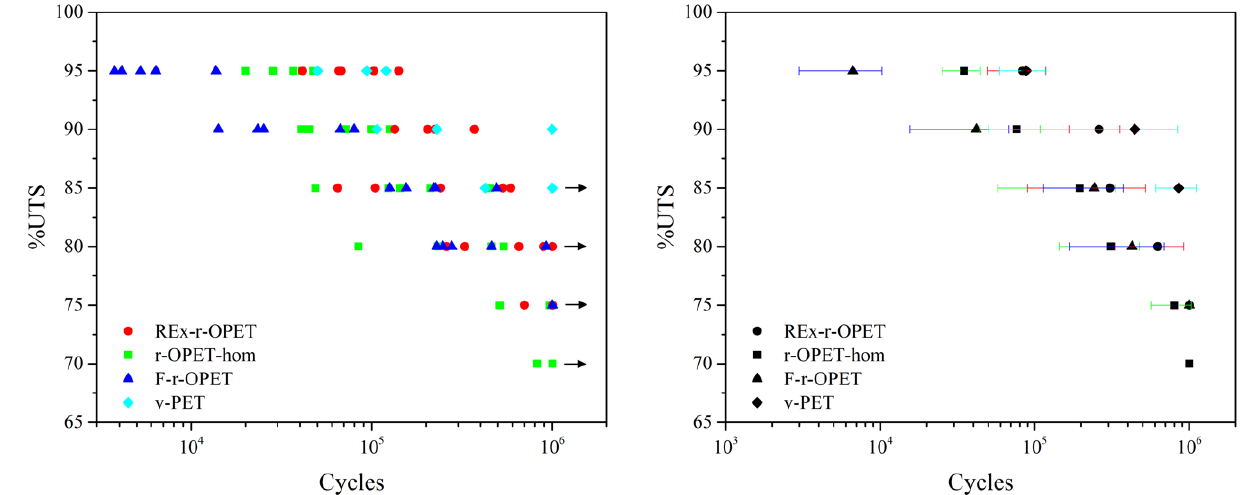
Figure 7. Fatigue life for various fatigue loads of PET specimens, left : All tested specimens (each coloured point assesses a specimen) black arrows indicate run-outs, right : Average of at least 3 values with its standard deviation.